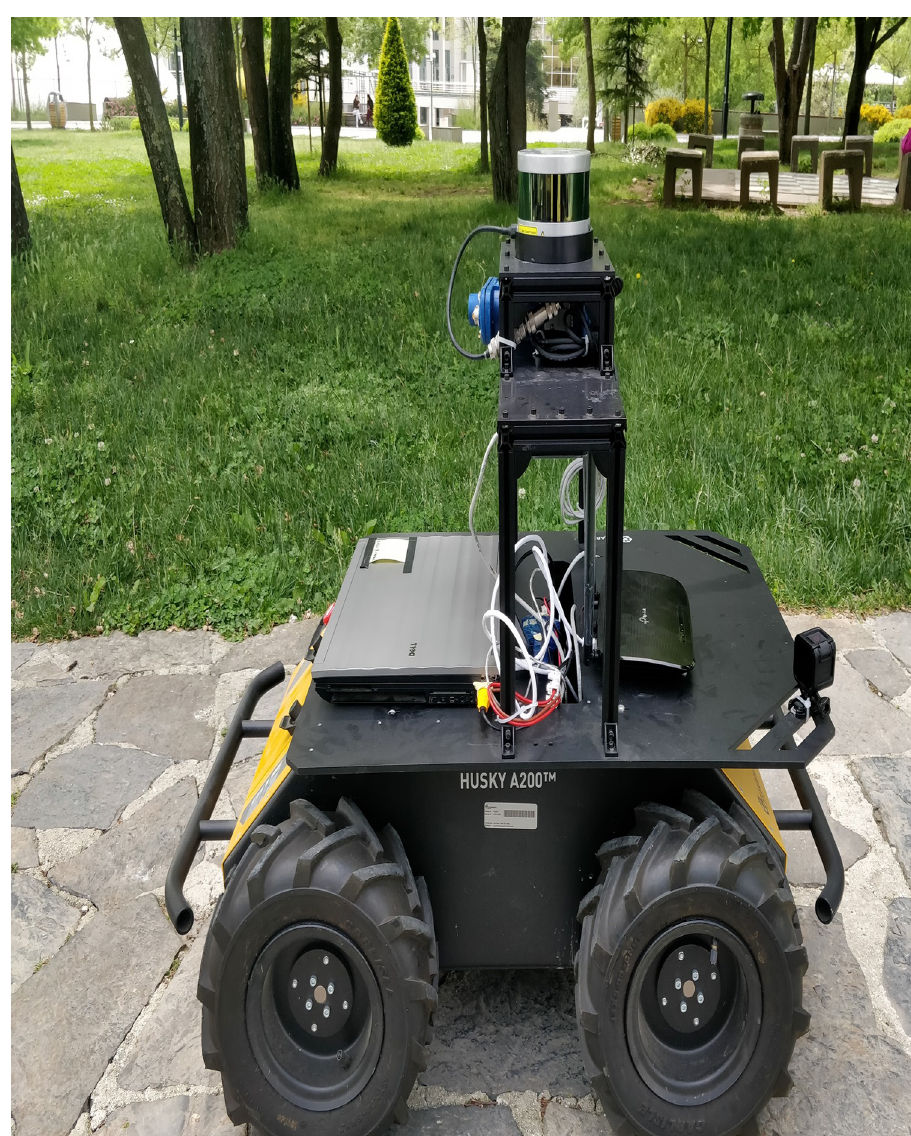
Fig 17. Clearpath Husky A-200 unmanned ground